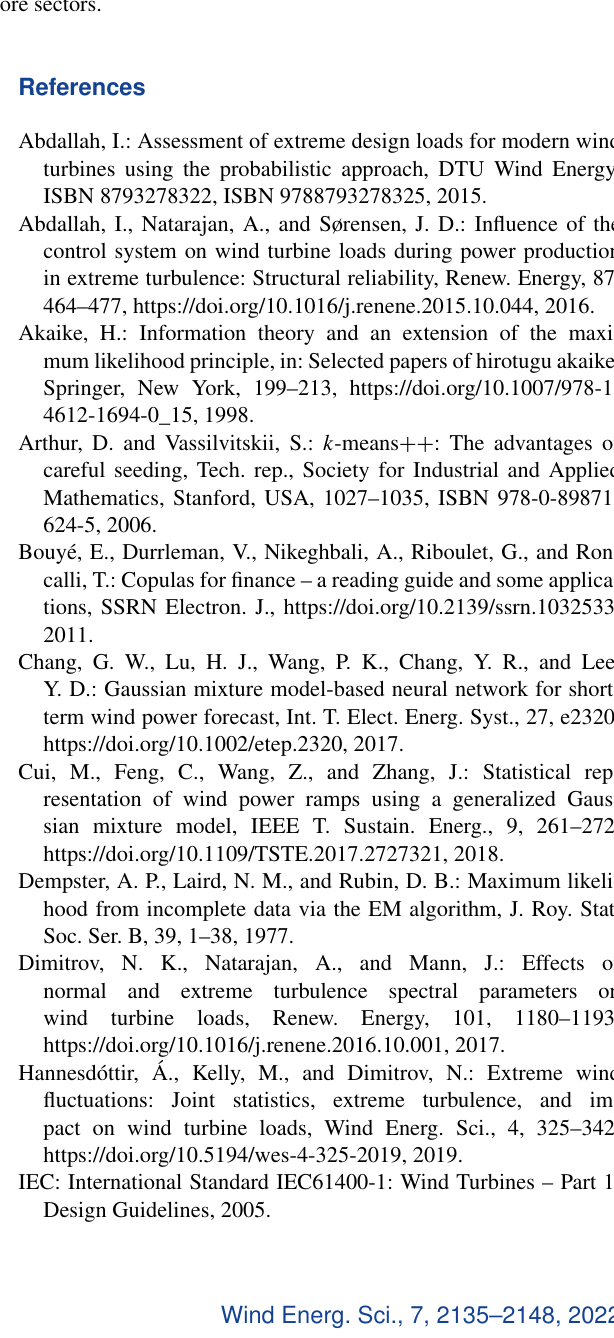
Figure 20. GMM and IEC 50-year turbulence estimation for two onshore